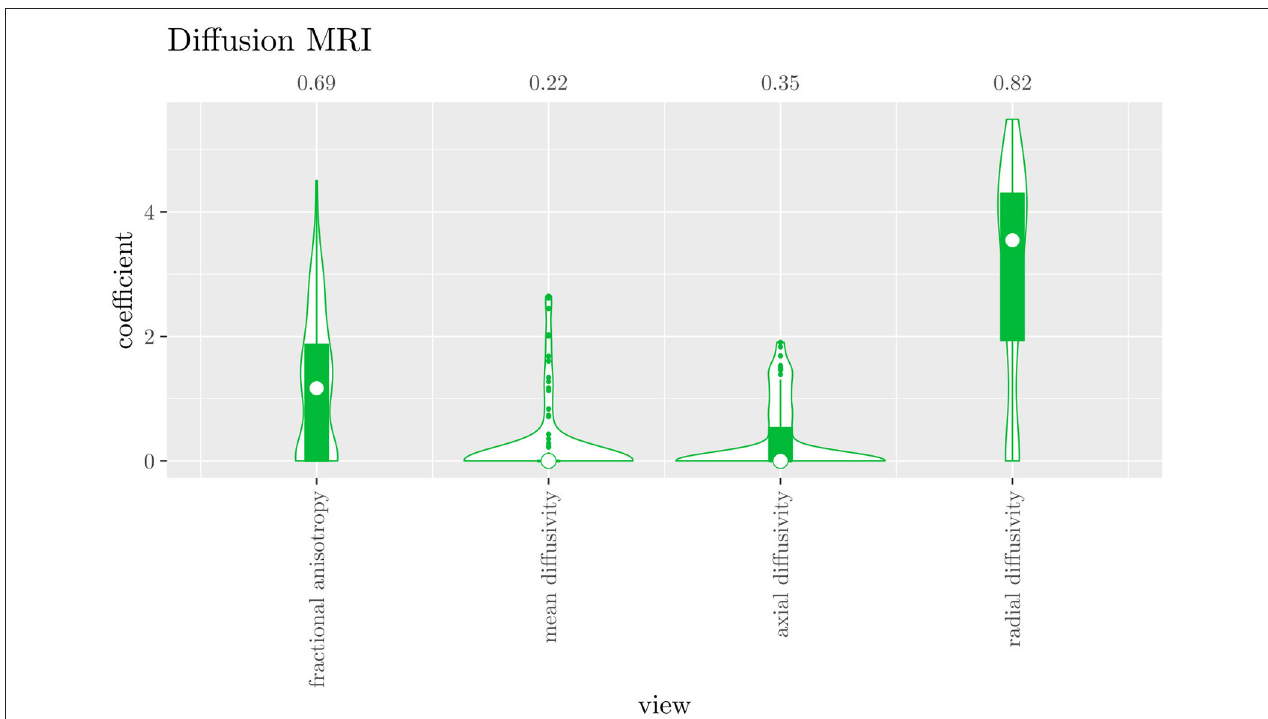
FIGURE 7 | Box-and-violin plots of the hierarchical StaPLR intermediate-level regression coefficients for the diffusion scan type. The numbers at the top of the graph denote the proportion of times the coefficient was nonzero.